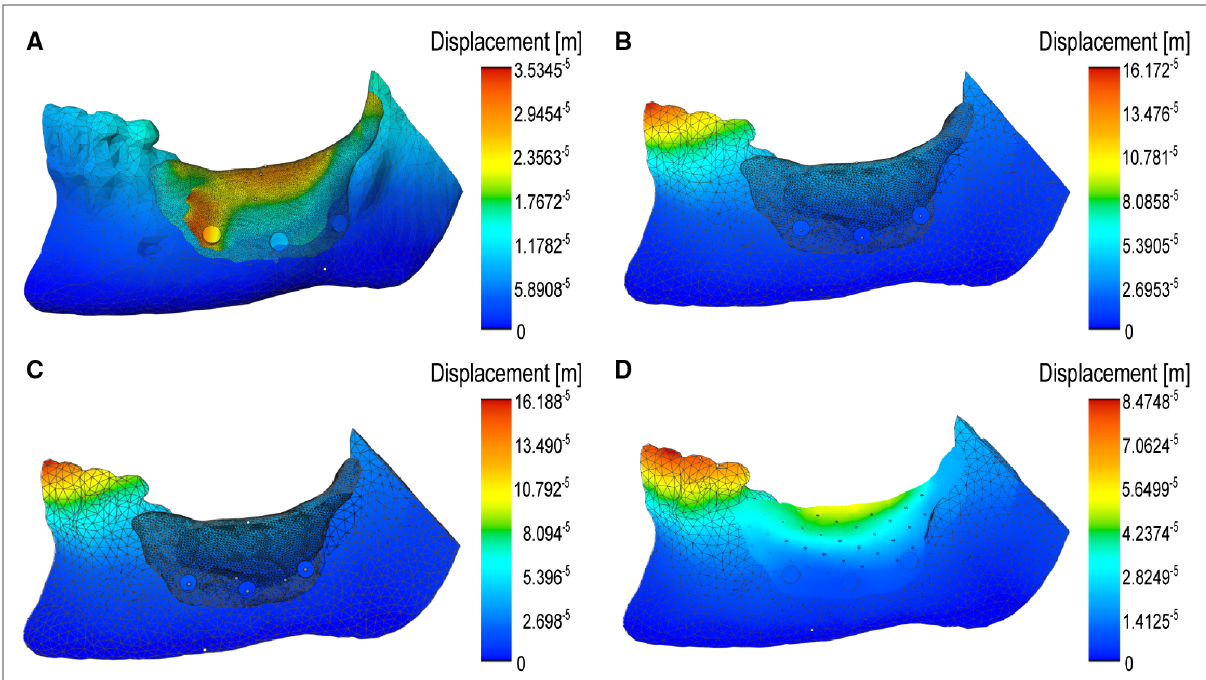
FIGURE 7 Computer modeling of surface displacements under masticatory force on the mandible and on the surgically placed device. ( A ) Large displacements over a thin (0.85 mm), compact PCL cover immobilized by facial screws: note their mostly lateral localization. ( B ) Much smaller surfaces displacements on the thicker (1.00 mm) compact cover. ( C ) Similar surface displacements of the cover after fi xing with both facial and lingual screws. ( D ) Larger but uniform distribution of the surface displacements of the porous cover, fi xed with facial